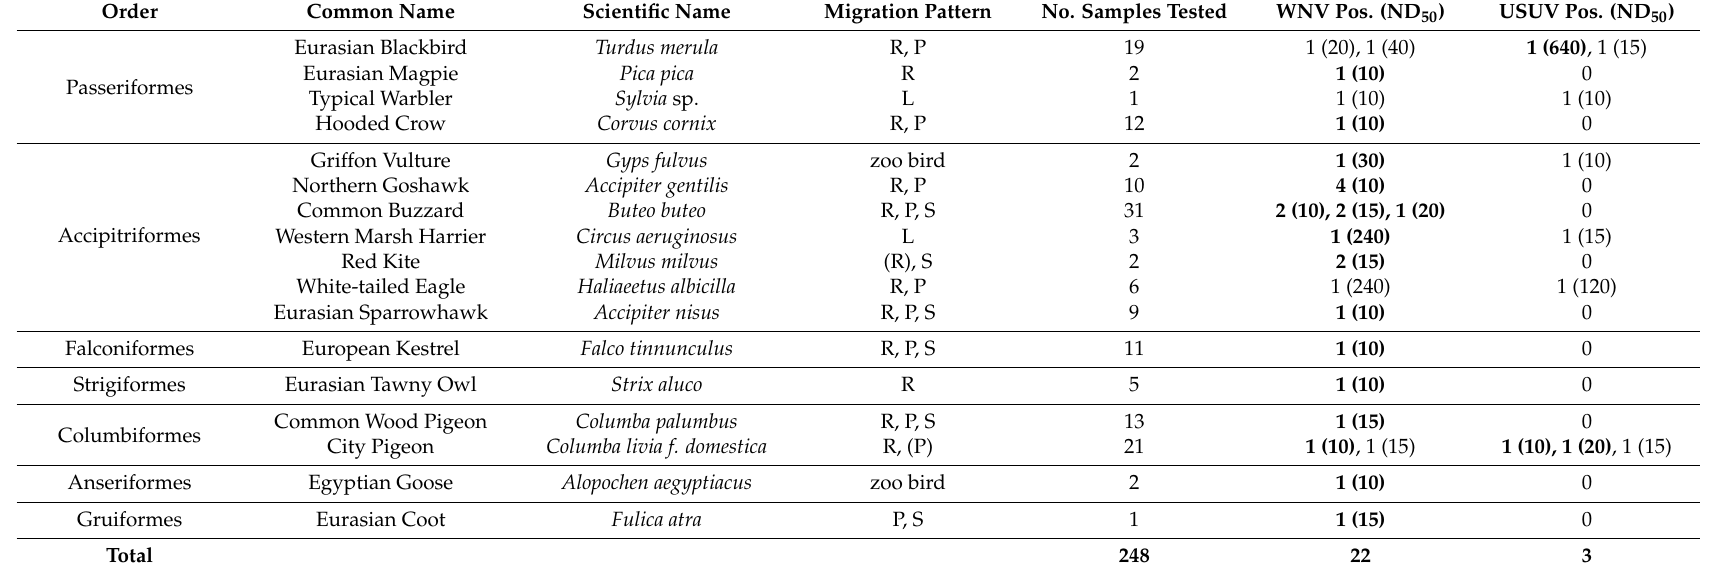
Table 4. WNV and USUV positive neutralization assay results (positives highlighted in bold) from wild bird serum samples in 2014.